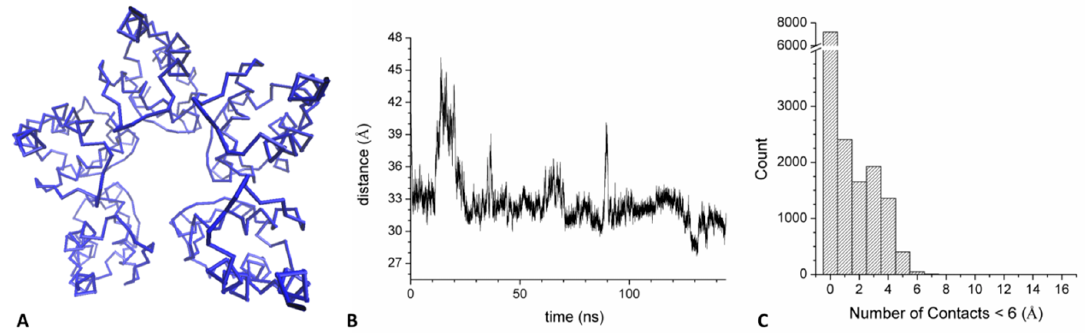
Figure 6. Average structure of KCTD12-16 BTB hetero-pentamer computed in the 50–150 ns region of the MD trajectory ( A ). Distance between the centers of mass of the two external domains that delimitate the gap ( B ). Distribution of the number of atoms of the two external domains that are within 6.0 Å ( C ).